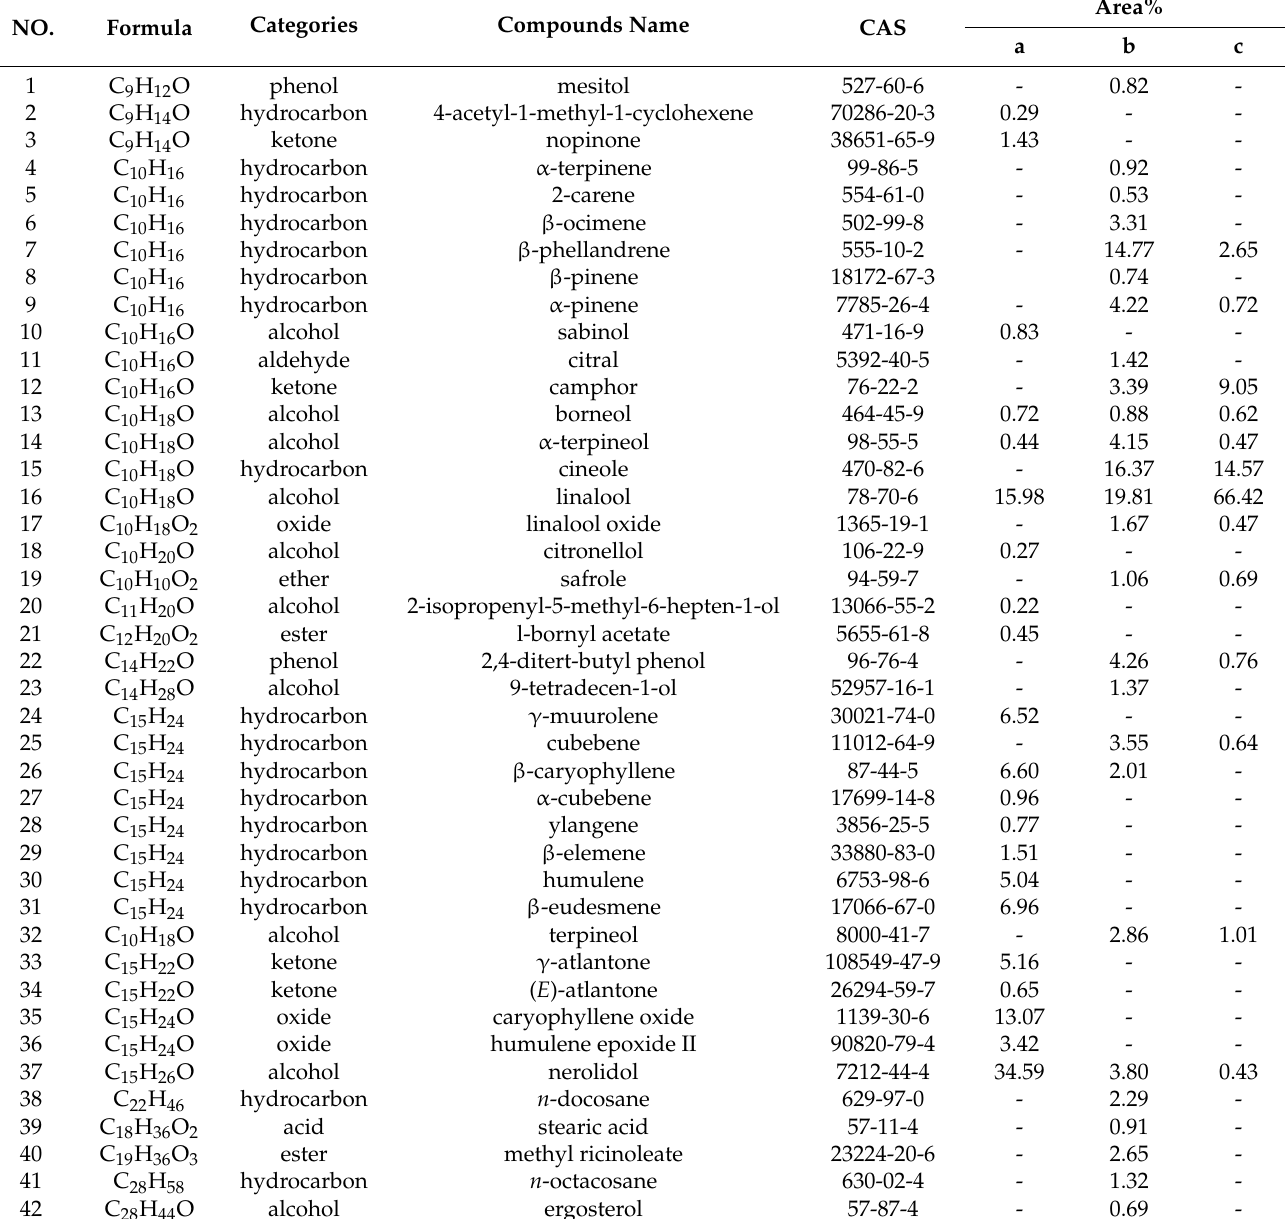
Table 3. Components and peak area percentages of essential oils under different conditions and